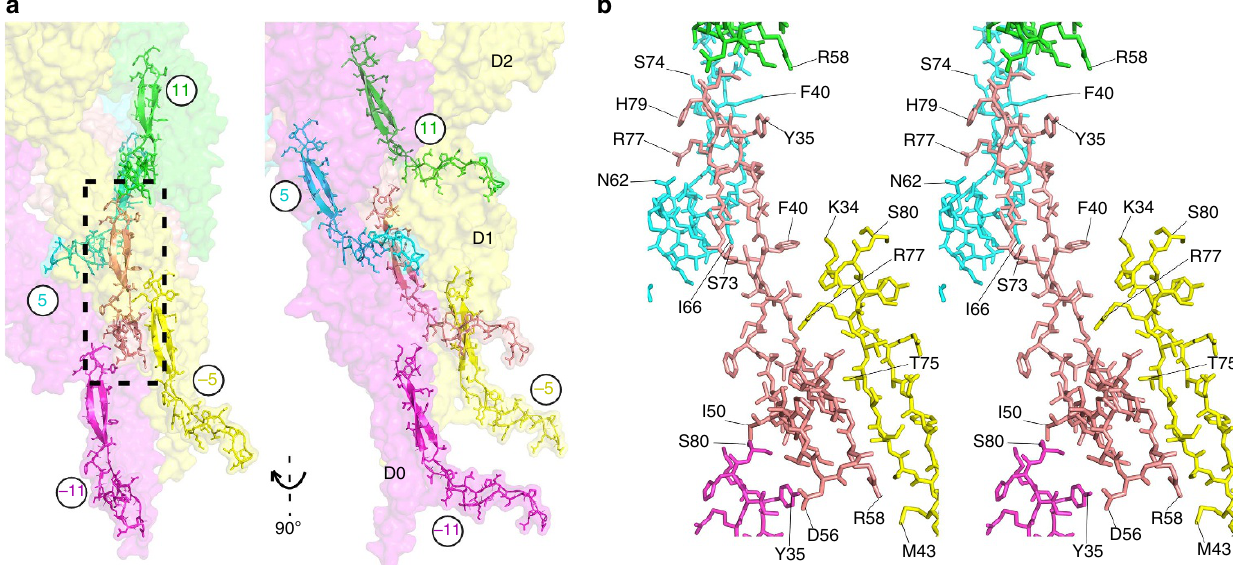
Figure 4 | Interactions between L -stretch motifs. The L -stretch interacts with other L -stretch motifs located in neighbouring protofilaments. ( a ) Overview of the position of the molecules involved in these interactions that are all restricted to domain D0. ( b ) A blown-up stereo view of the interactions between L -stretch motifs. These interactions are in the 5-start and in the 11-start directions, in the surrounding protofilaments and within the same protofilament, respectively. The circled numbers indicate the order of appearance of each FlgE molecule during the building of the hook (Supplementary Fig. 3). Figure prepared with the second mutant strain (CB-A46) encodes a mutant flgE gene deleted for codons for the D3 and D4 domains integrated onto the chromosome within the rRNA gene cluster (Fig. 7).